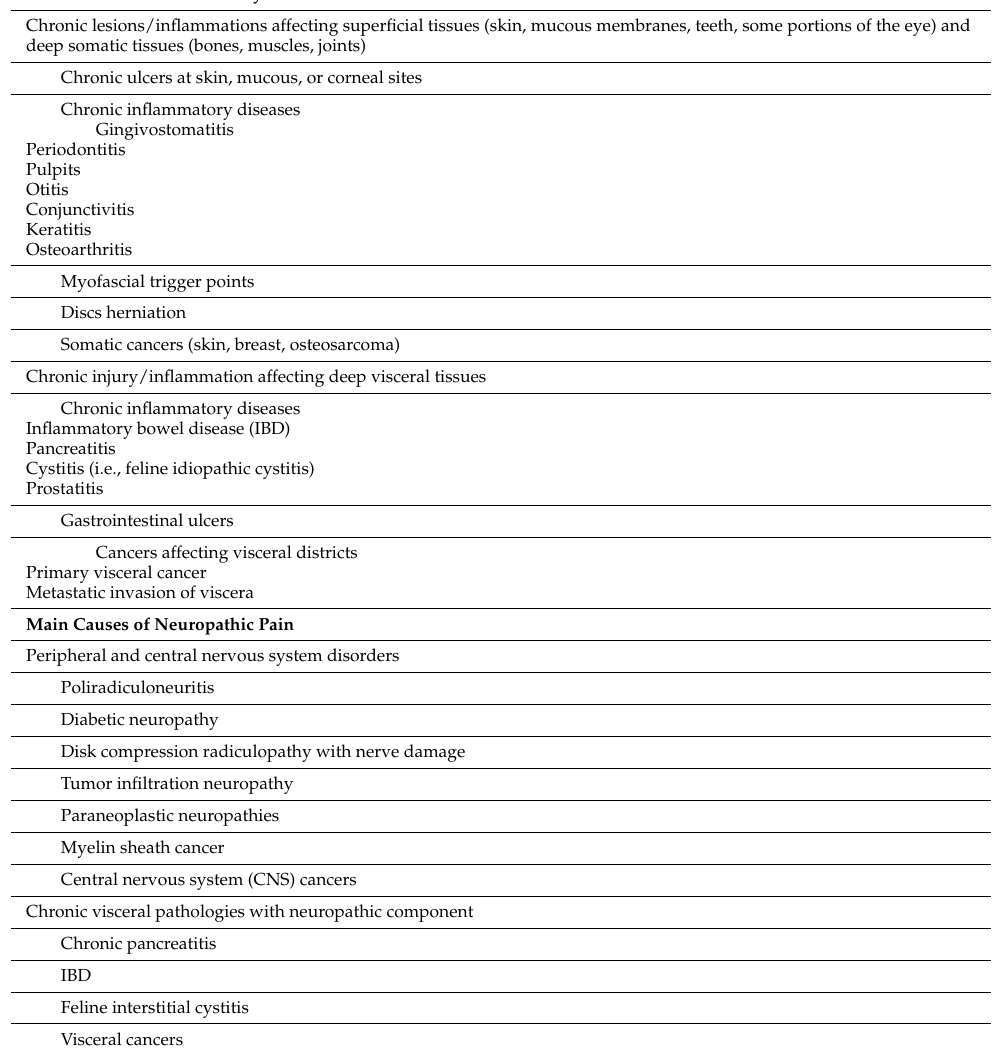
Table 2. Main causes of maladaptive pain in dogs and cats. From